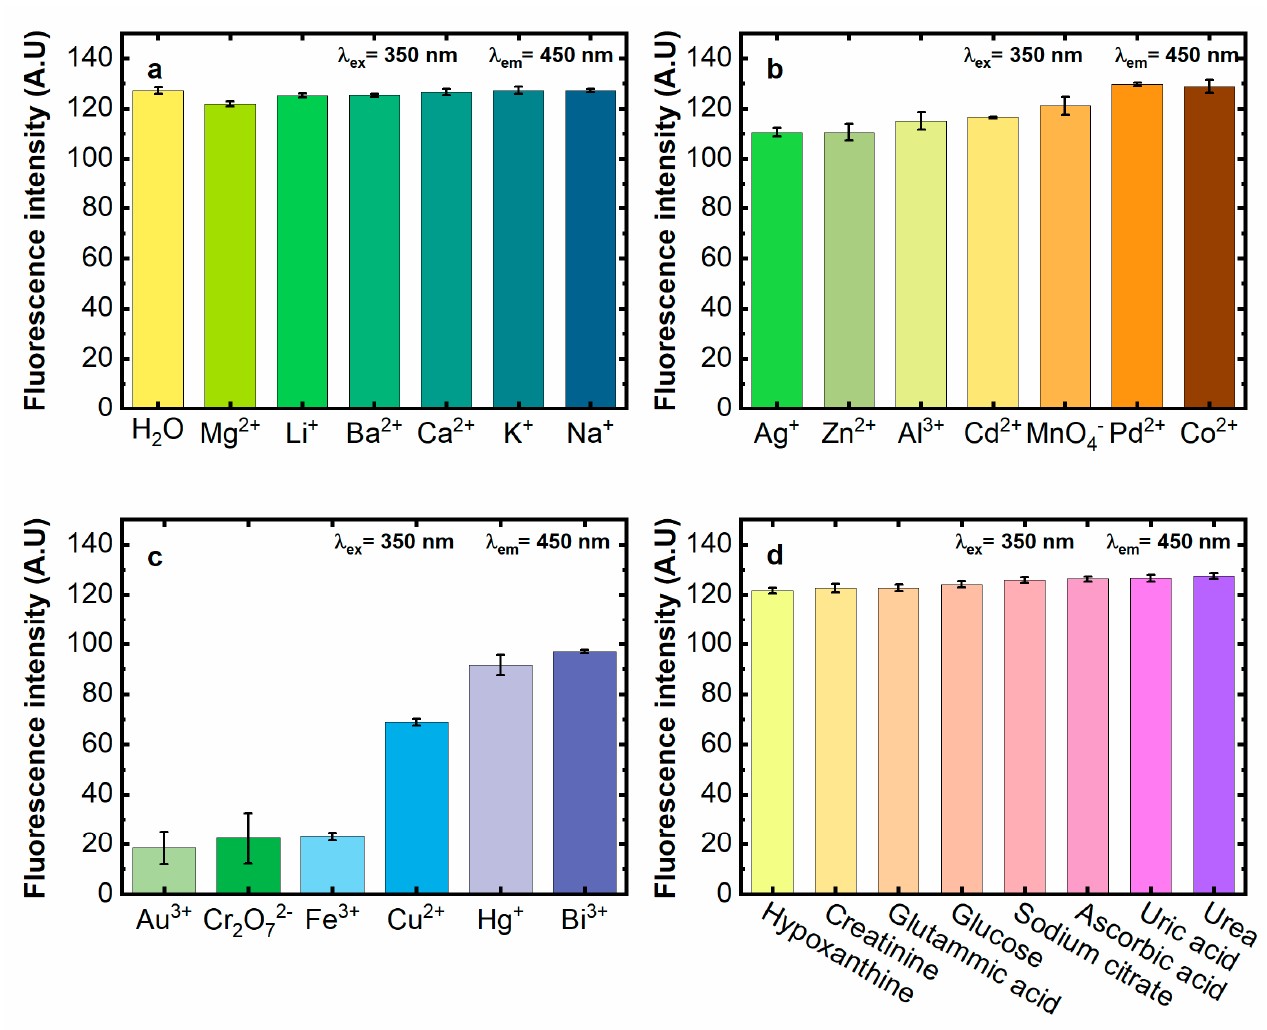
Figure 5. Fluorescence of the SEDF in 10 mM TRIS at pH 9.00 after the addition of 0.5 mM alkaline and alkaline earth metals ( a ), transition metals ( b , c ), and organic compounds occurring in urine ( d ). The error bars represent the standard deviation (n = 4).